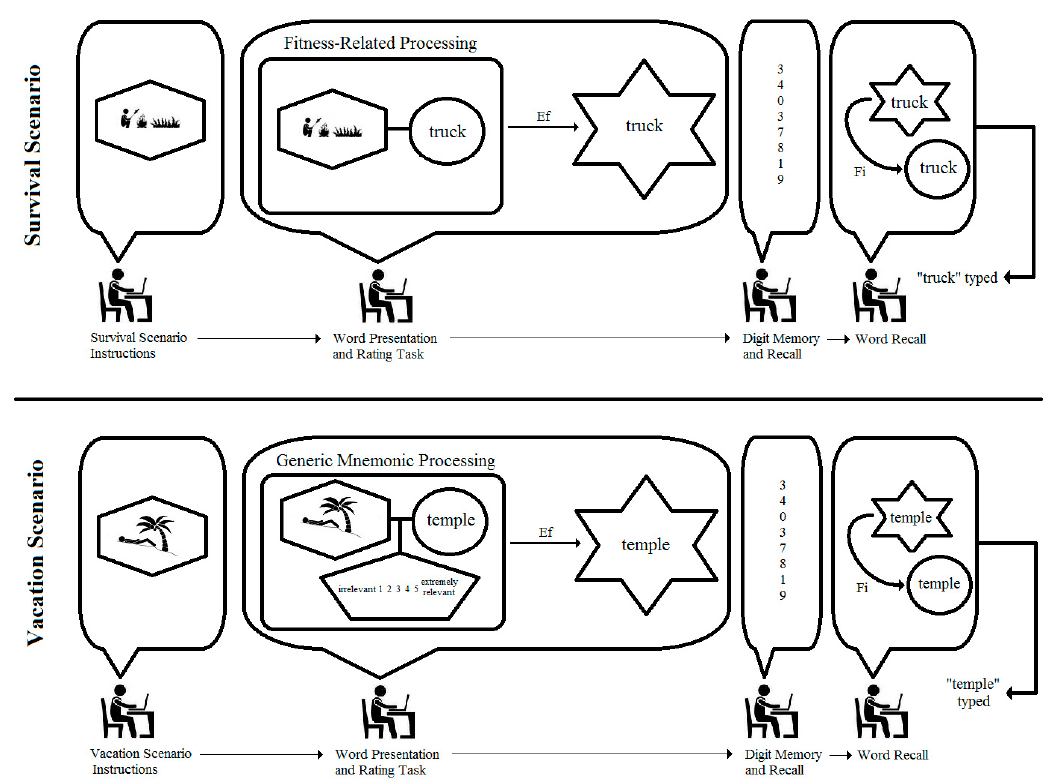
Figure 4. Model representing fitness-related and generic mnemonic processing of the words “truck” and “temple.” Visual images are represented as elongated hexagons; simple predication is represented as a circle; complex judgments are represented as pentagons; memory storage is represented as hexagrams; “Ef” represents efficient cause, and “Fi” represents final cause.